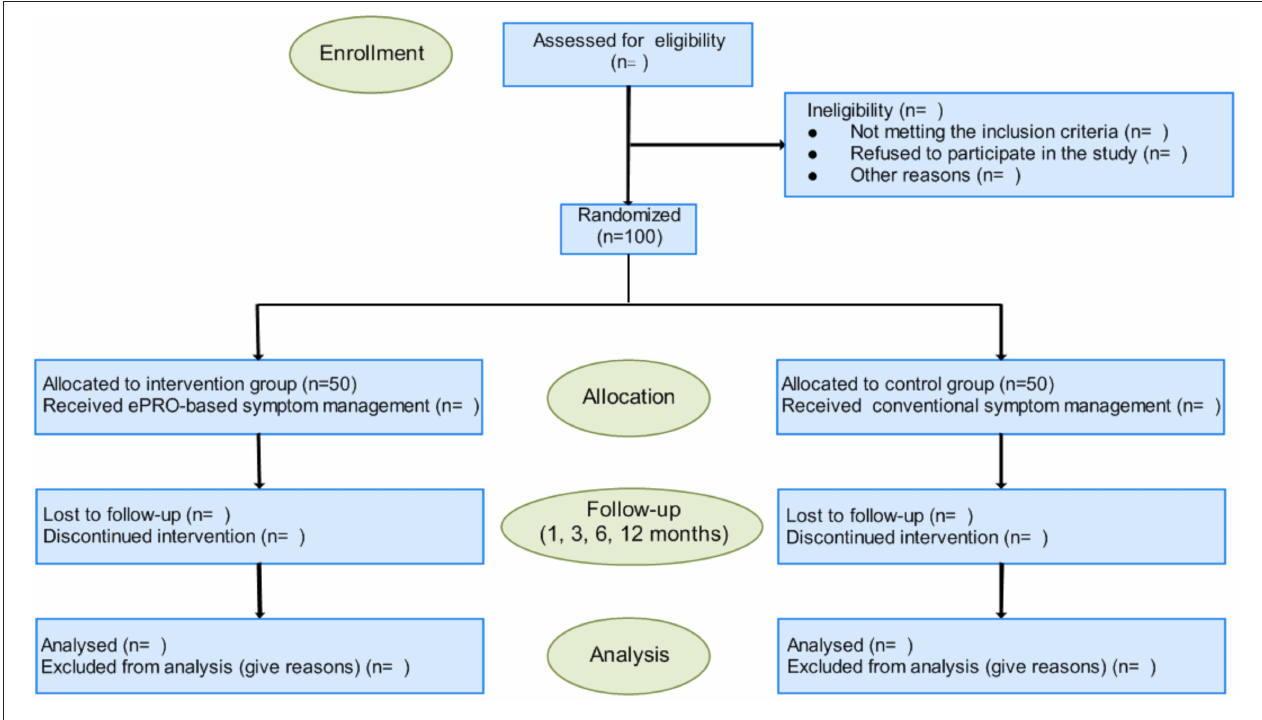
FIGURE 1 | Flow diagram of the